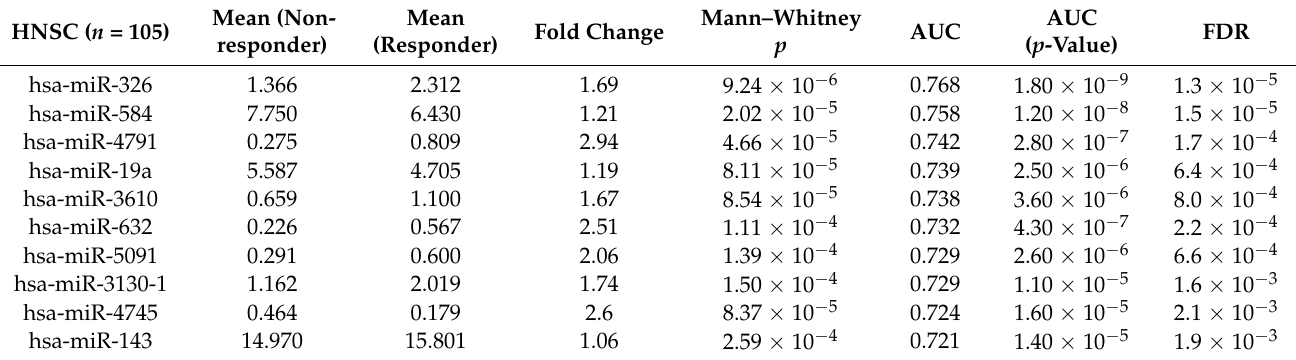
Table 3. Top ten miRNA biomarker candidates of platinum-based therapy in head and neck cancer (HNSC). HNSC ( n = 105)